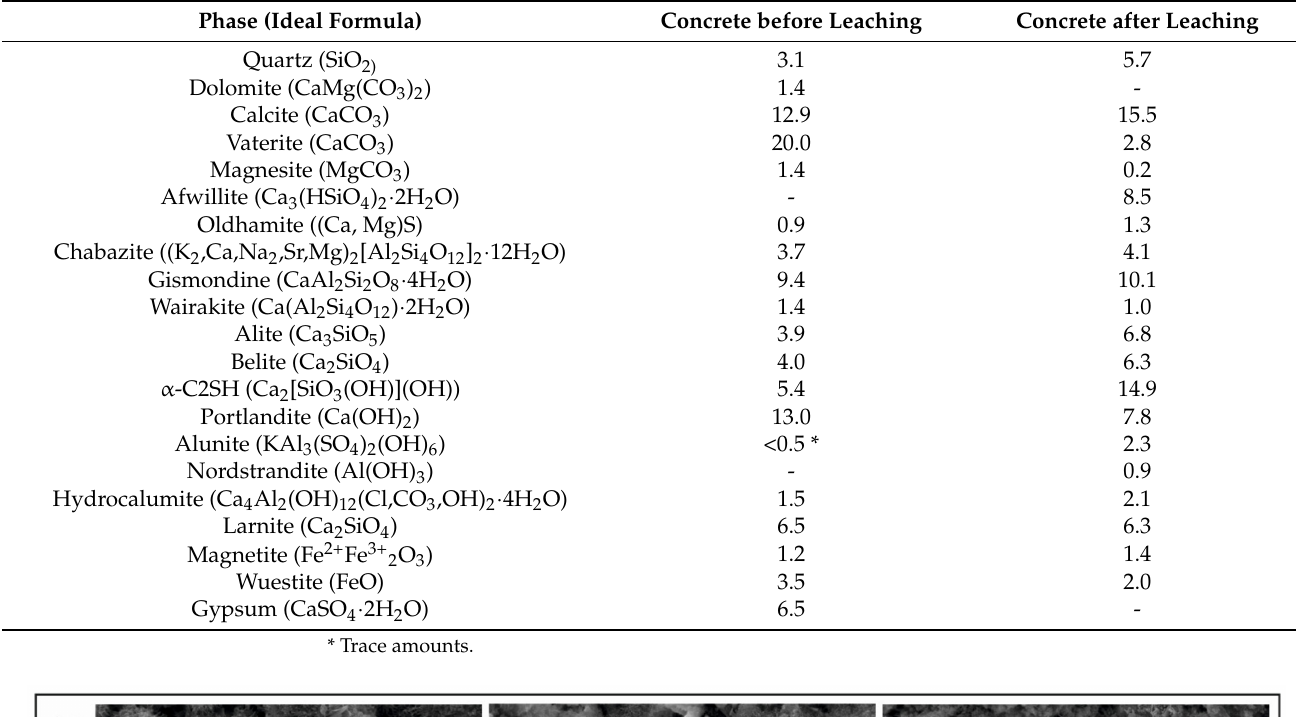
Table 4. Phase composition of concrete.